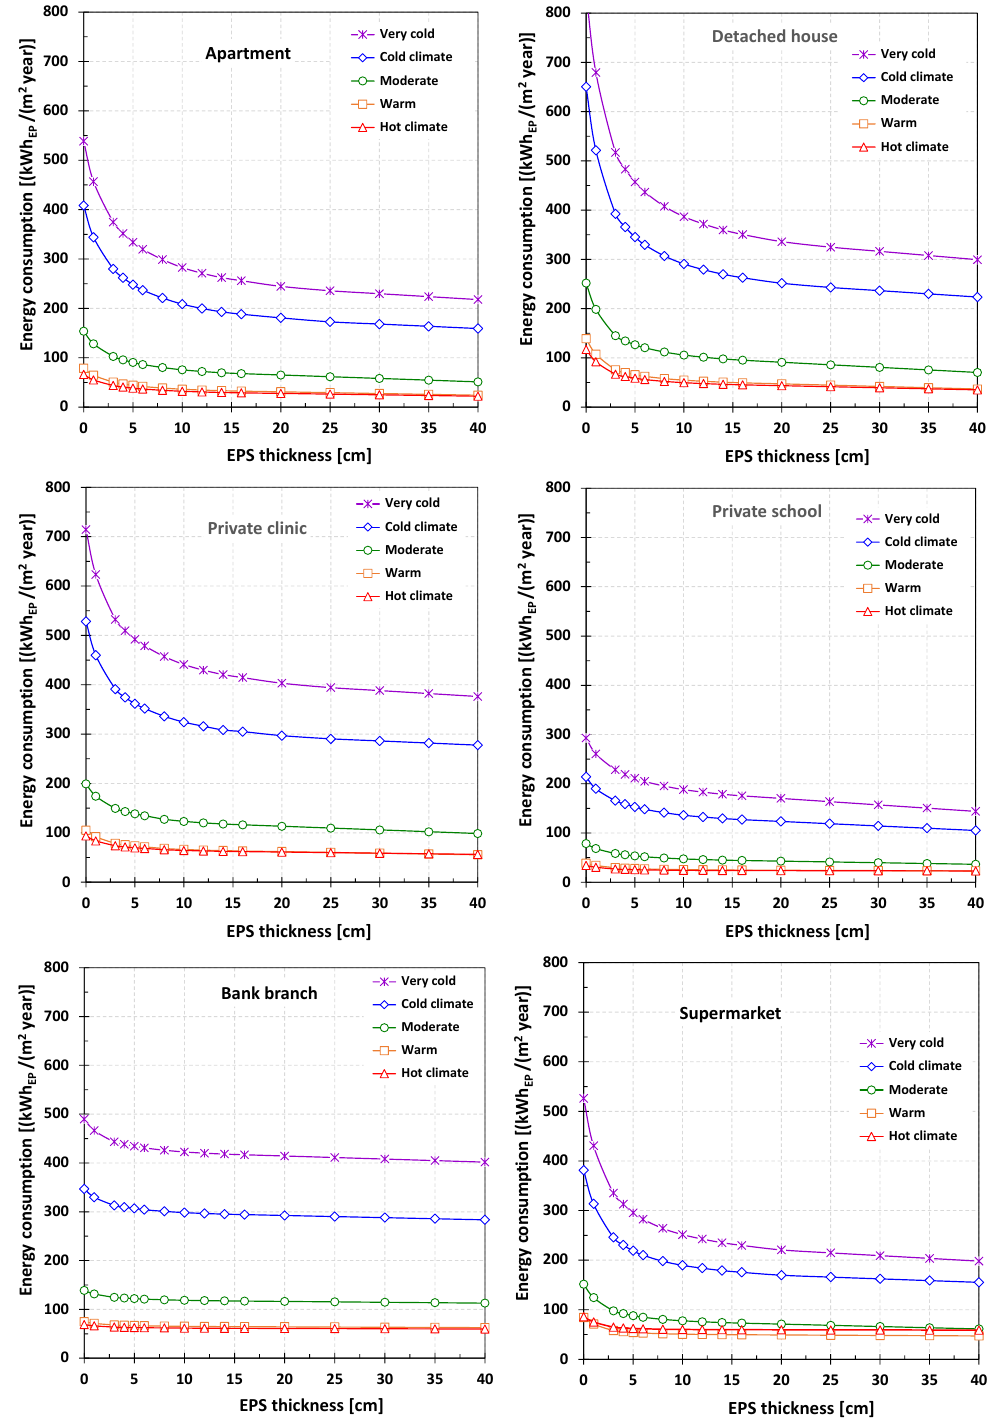
Figure 4. Primary energy consumption for heating and cooling, to maintain thermal comfort.